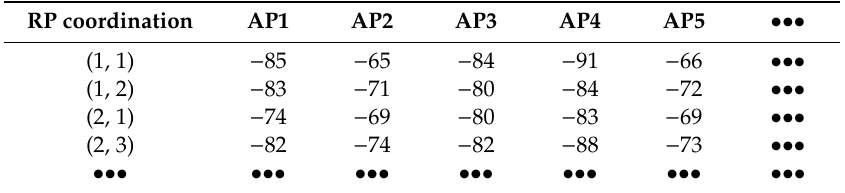
Figure 6. The chemical plant floor plan of a coking company. Table 2. Fingerprint data.